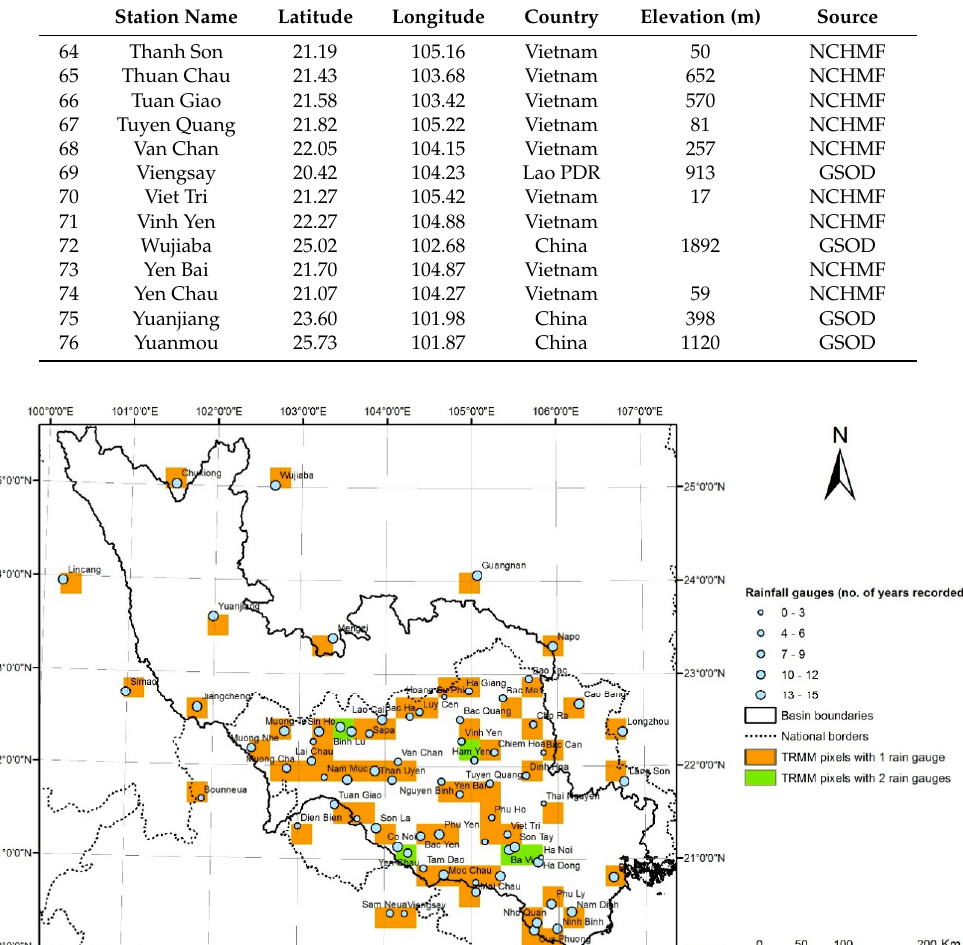
Figure A2. Comparison of TRMM data with measured monthly rainfall averaged per pixel for gauges in pixels with multiple stations. The red line gives the linear regression best fit with 0 intercept.